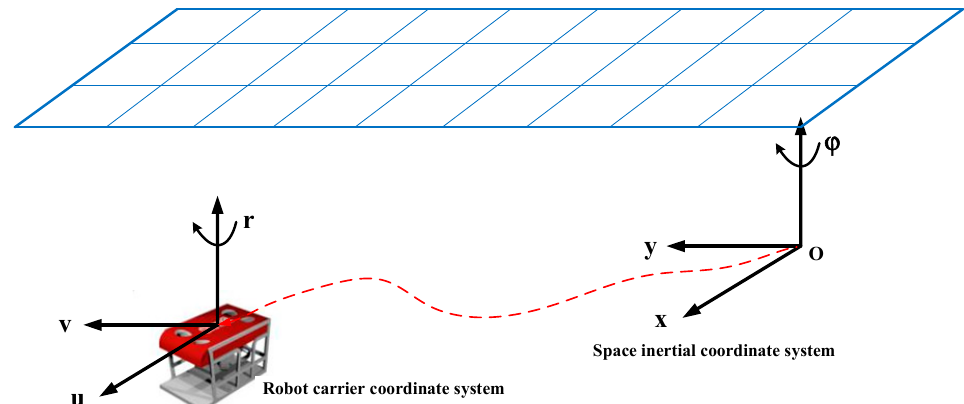
Figure 1. Three-degree-of-freedom model of underwater vehicle.